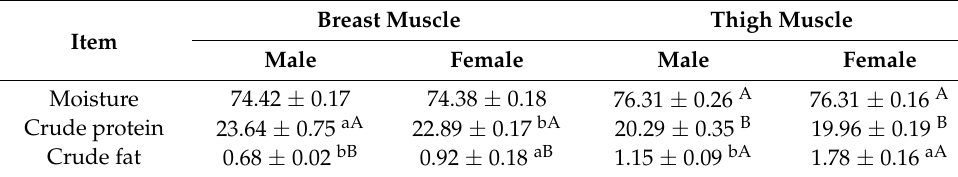
Table 1. Chemical composition of breast and thigh muscles of Wuliangshan Black-bone chickens (g/100g